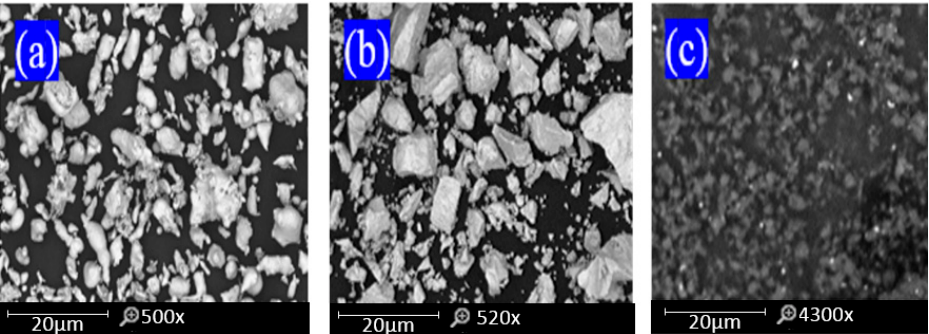
Figure 1. SEM images of ( a ) 316L SS, ( b ) niobium, and ( c ) boron powder.